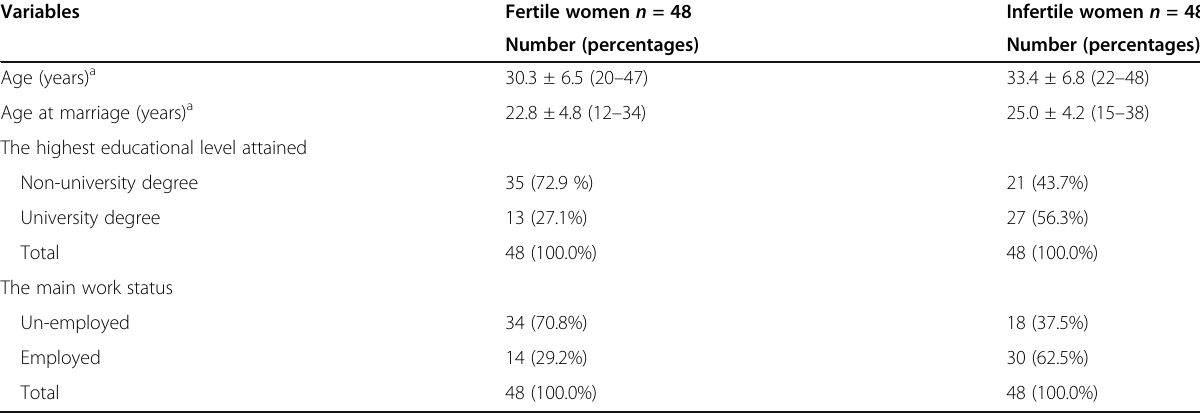
Table 1 Socio-demographic characteristics of fertile and infertile women attending MNH, Dar es Salaam, Tanzania Variables